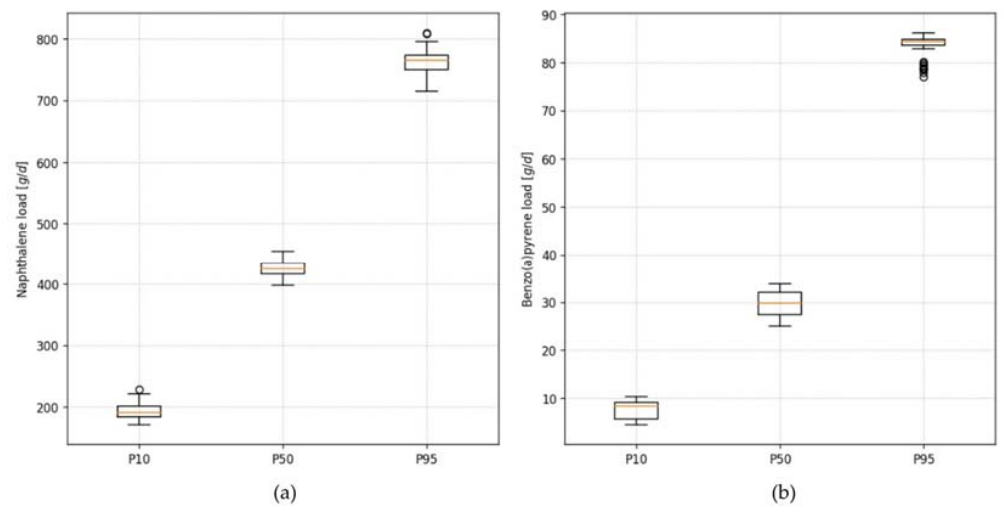
Figure 2. Input loads of ( a ) naphthalene and ( b ) benzo(a)pyrene for 10%, 50%, and 95% probability percentiles.